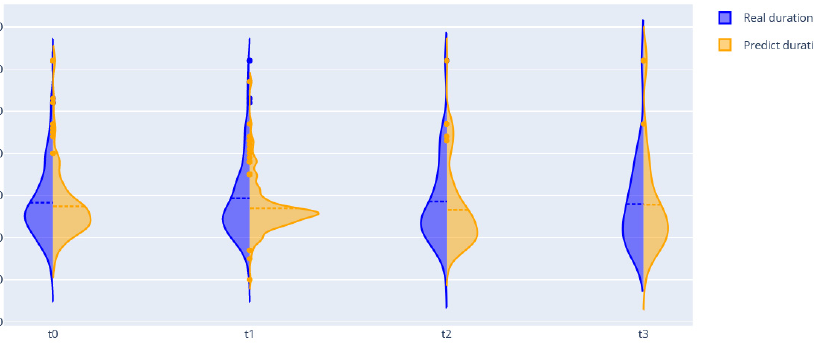
Figure 7. Real and predicted probability distributions of length of stay for predictions using information from different time intervals.